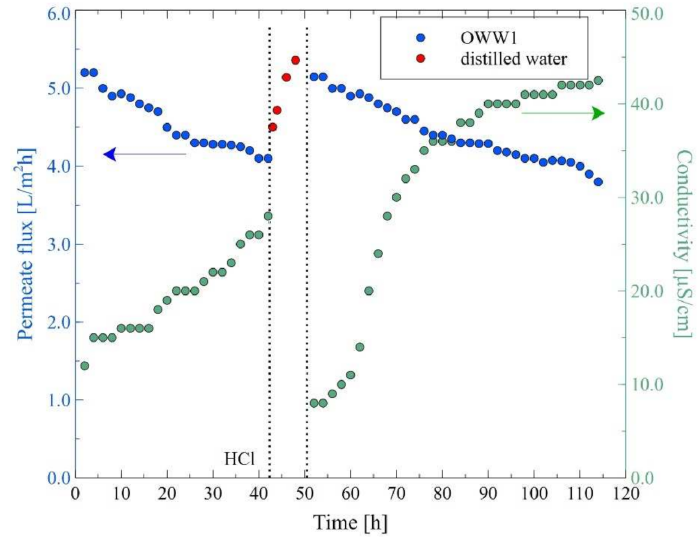
Figure 16. Changes in the permeate flux and distillate conductivity. Feed: oily wastewater OWW1, T F = 343 K, v F = 0.12 m/s. Module M4. At 42 h—module rinsed by 3% HCl, next module flushed by distilled water.